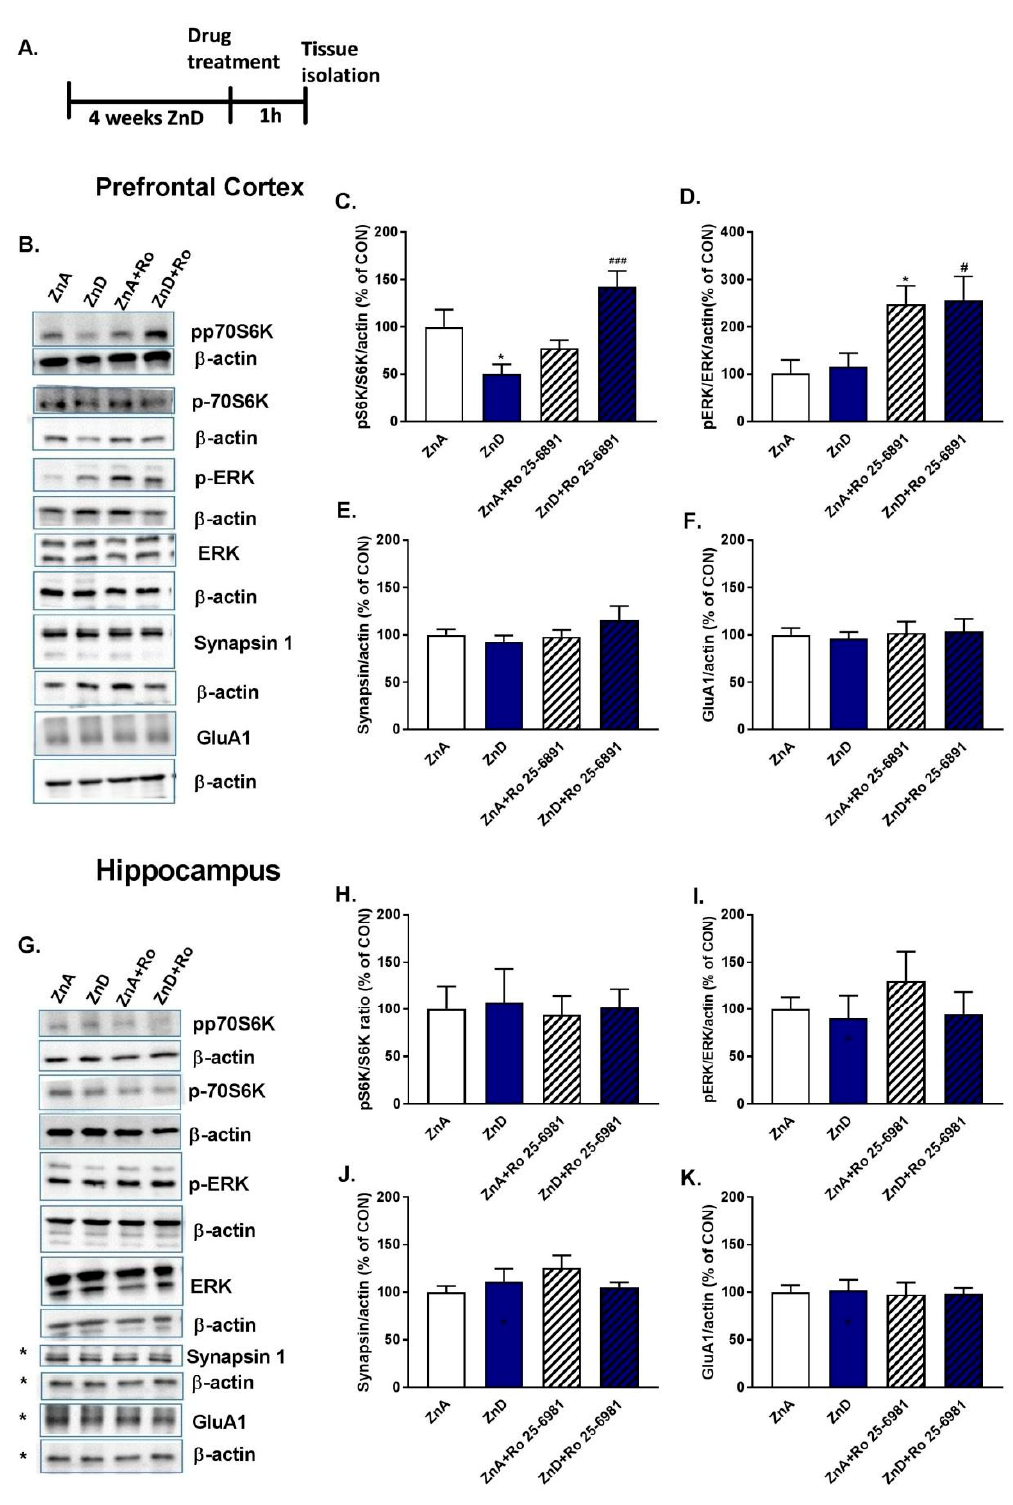
Figure 3. The e ff ect of the administration of single dose of Ro 25–6981 on the expression of pS6K / S6K, p-ERK / ERK, synapsin I and GluA1 subunit of AMPA receptors in the prefrontal cortex (PFC) and hippocampus (Hp) of rats subjected to ZnD, n = 8–10; ( A ) experimental schedule; ( B ) representative blots for PFC; ( C – F ) protein expression in PFC; ( G ) representative blots for Hp, * images from the same part of the membrane; ( H – K ) protein expression in Hp. All data were analyzed by two-way ANOVA and the Newman–Keuls multiple comparisons test. All values are expressed as mean ± S.E.M. PFC: ( B ) pS6K / S6K: interaction [F(1,31) = 17.18, p = 0.0002]; e ff ect of Ro 25–6981 [F (1, 31) = 6.335, p =